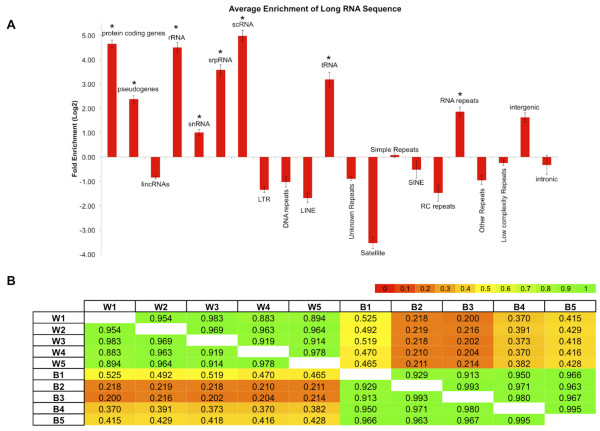
Enriched elements and pseudogenes. A) Enrichment analysis of the expressed genomic elements. Shown is the average enrichment for the 10 sequenced samples for various categories of annotated transcripts. The x-axis is the genomic element and the y-axis is the average enrichment value (log2) for each category. Values are averaged across all ten samples. Those categories reaching significant enrichments (P-value < = 0.05) are indicated with a “*”. B) Pseudogenes. Heatmap of the inter-individual Pearson correlations of pseudogene transcripts (RNA-seq). The sample IDs are labeled with a W (White) or B (Black).